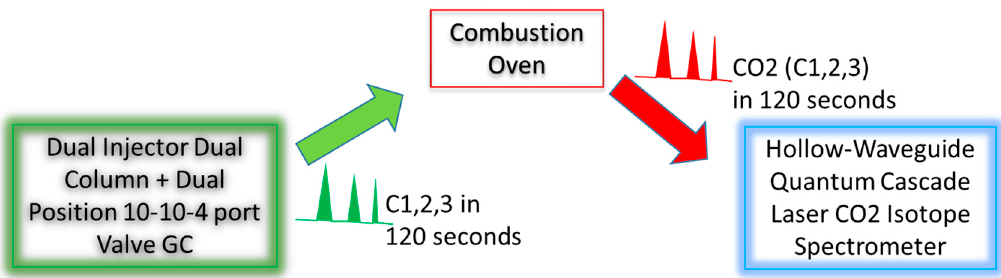
Figure 1. Schematic of the GC–IR 2 system. The GC–IR 2 system include three modules, and the mud gas samples are separated in the GC from which only C1,2,3 peaks are separated and output in 120 s. The three peaks are then combusted in the oven and then analyzed in the quantum cascade laser hollow-waveguide CO 2 isotope spectrometer.